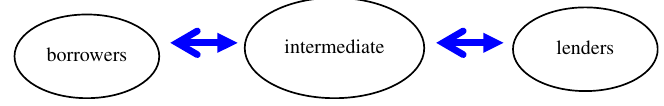
Fig. 1. The most basic illustration of the funding structure, where Table 1 complements the ¯gure's explanation and explains who the various parties are in the ¯gure.